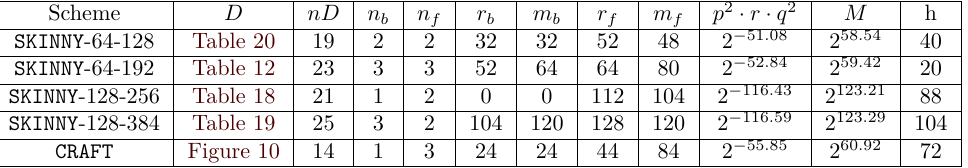
Table 13: Summary of the used parameters through our key recovery attacks on the variants of SKINNY and CRAFT , where D , nD , n number of rounds of the distinguisher, the number of rounds appended and the number of rounds